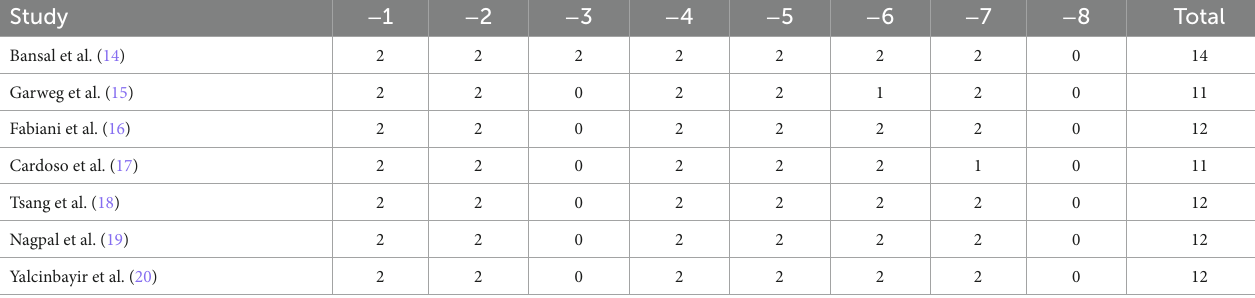
TABLE 3 The quality of included studies based on the MINORS. Study